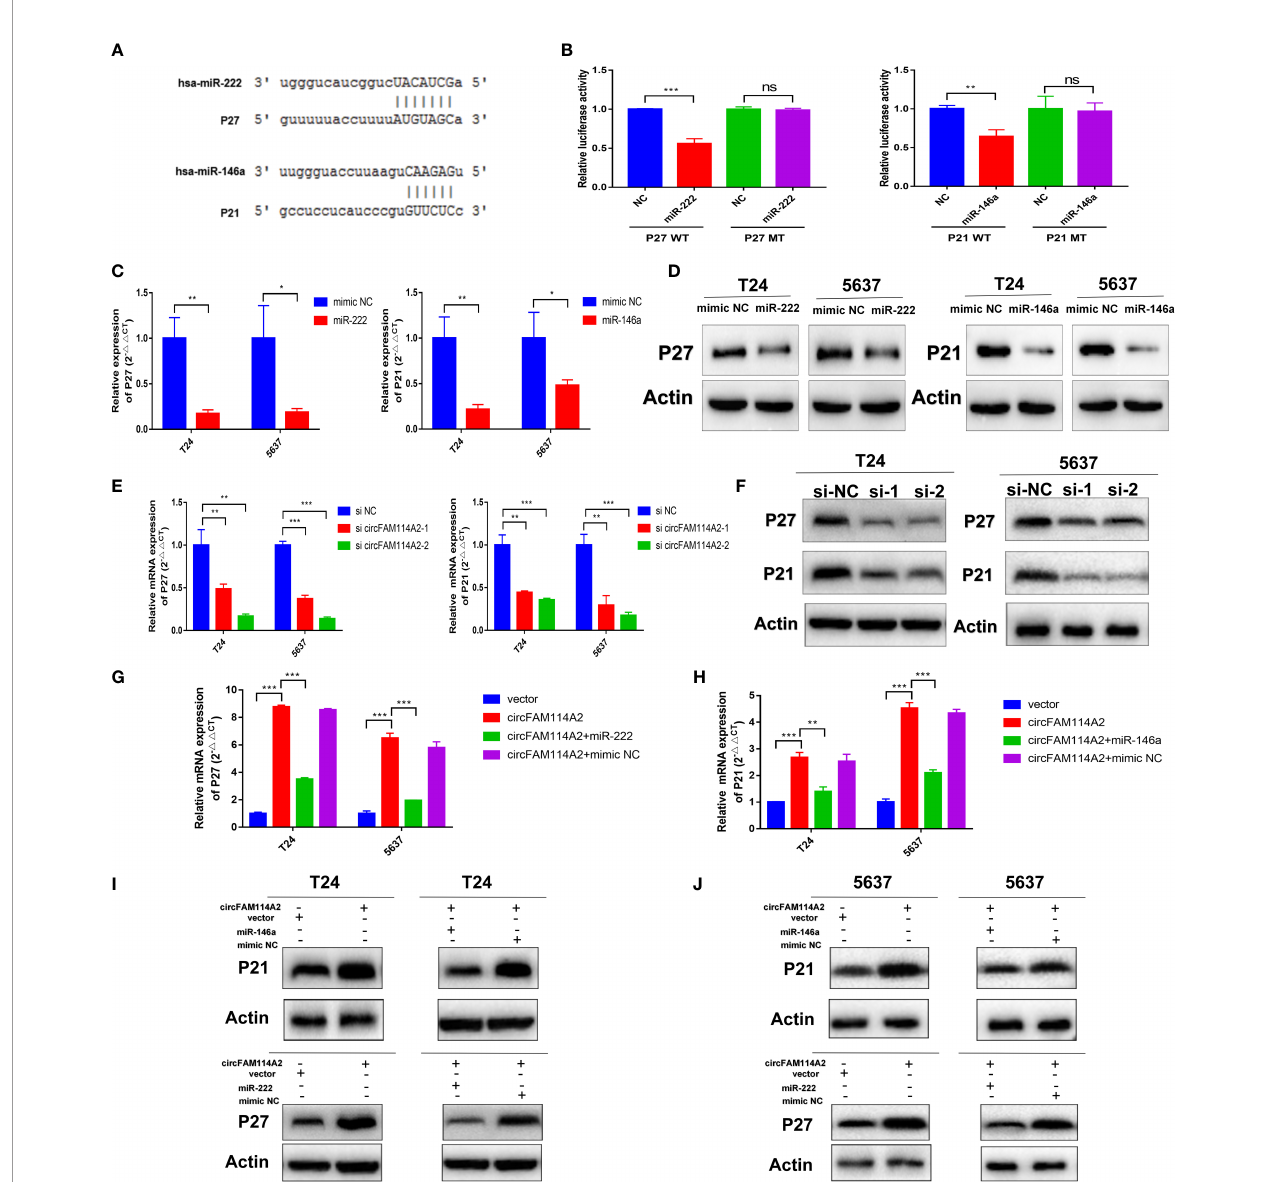
FIGURE 6 | CircFAM114A2 in fl uenced the expressions of P27 and P21 through sponging miR-222-3p and miR-146a-5p. (A) Predicted miR-222-3p/miR-146a-5p binding sites in the 3 ′ -UTRs of P27 / P21 mRNA by bioinformatics analysis. (B) Dual-luciferase reporter assays demonstrated that P27 and P21 are direct targets of miR-222-3p and miR-146a-5p, respectively (Student ’ s t -test: ** p < 0.01, *** p < 0.001). ns, no signi fi cant. (C) MiR-222-3p/miR-146a-5p could reduce the expressions of P27 / P21 in T24 and 5637 cells detected by quantitative real-time PCR (qRT-PCR) (Student ’ s t -test: * p < 0.05, ** p < 0.01). (D) MiR-222-3p/miR- 146a-5p could reduce the expressions of P27 / P21 in T24 and 5637 cells detected by Western blot. (E) qRT-PCR results indicated that the knockdown of circFAM114A2 downregulated the mRNA expression levels of P27 and P21 in T24 and 5637 cells (Student ’ s t -test: ** p < 0.01, *** p < 0.001). (F) Western blot results showed that the knockdown of circFAM114A2 downregulated the protein expression levels of P27 and P21 . (G, H) Overexpression of circFAM114A2 upregulated the mRNA expression levels of P27 and P21 in T24 and 5637 cells, which could be reversed by co-transfection with miR-222-3p and miR-146a-5p, respectively (Student ’ s t -test: ** p < 0.01, *** p < 0.001). (I, J) Overexpression of circFAM114A2 upregulated the protein expression levels of P27 and P21 , which could be reversed by co-transfection with miR-222-3p and miR-146a-5p, respectively. Data are the mean ± SD, n = 3